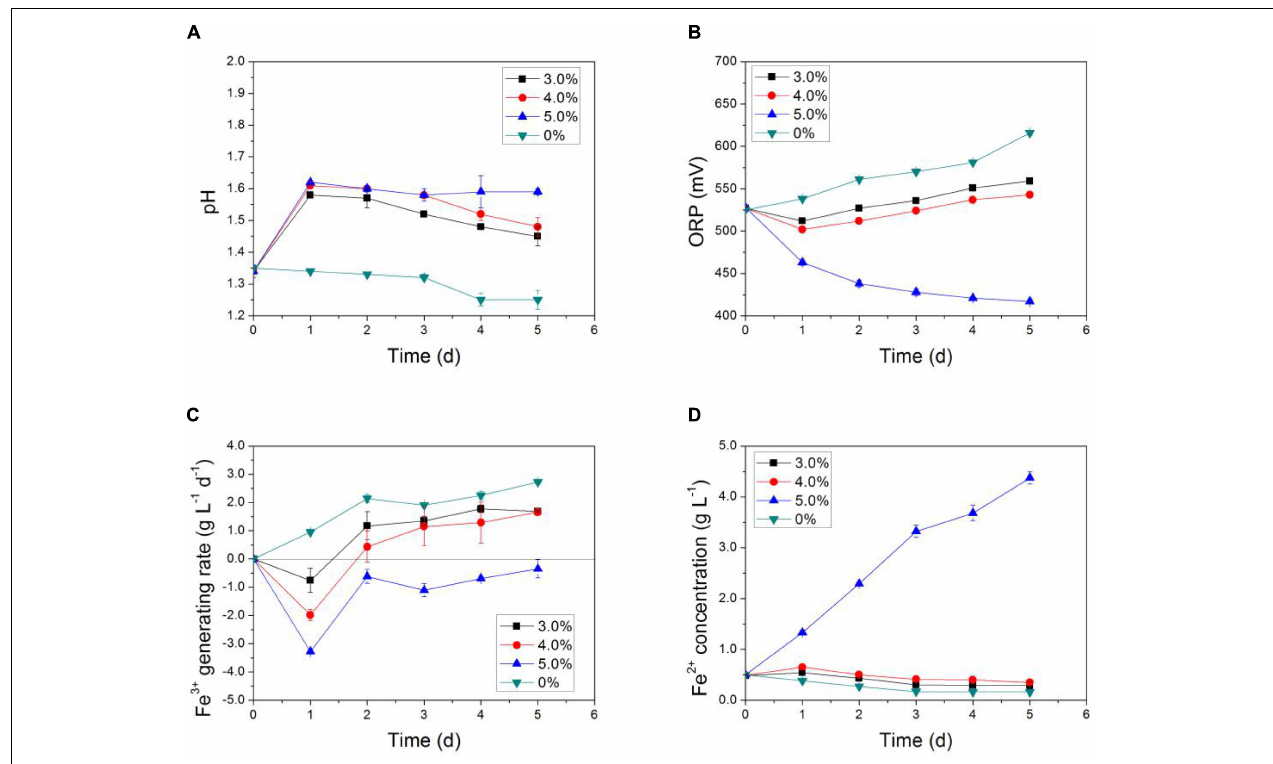
FIGURE 5 | Time-courses for (A) pH, (B) ORP, (C) Fe 3 + generation rate, and (D) Fe 2 + concentration in simulated bioleaching system with varied pulp density of LiCoO 2 .